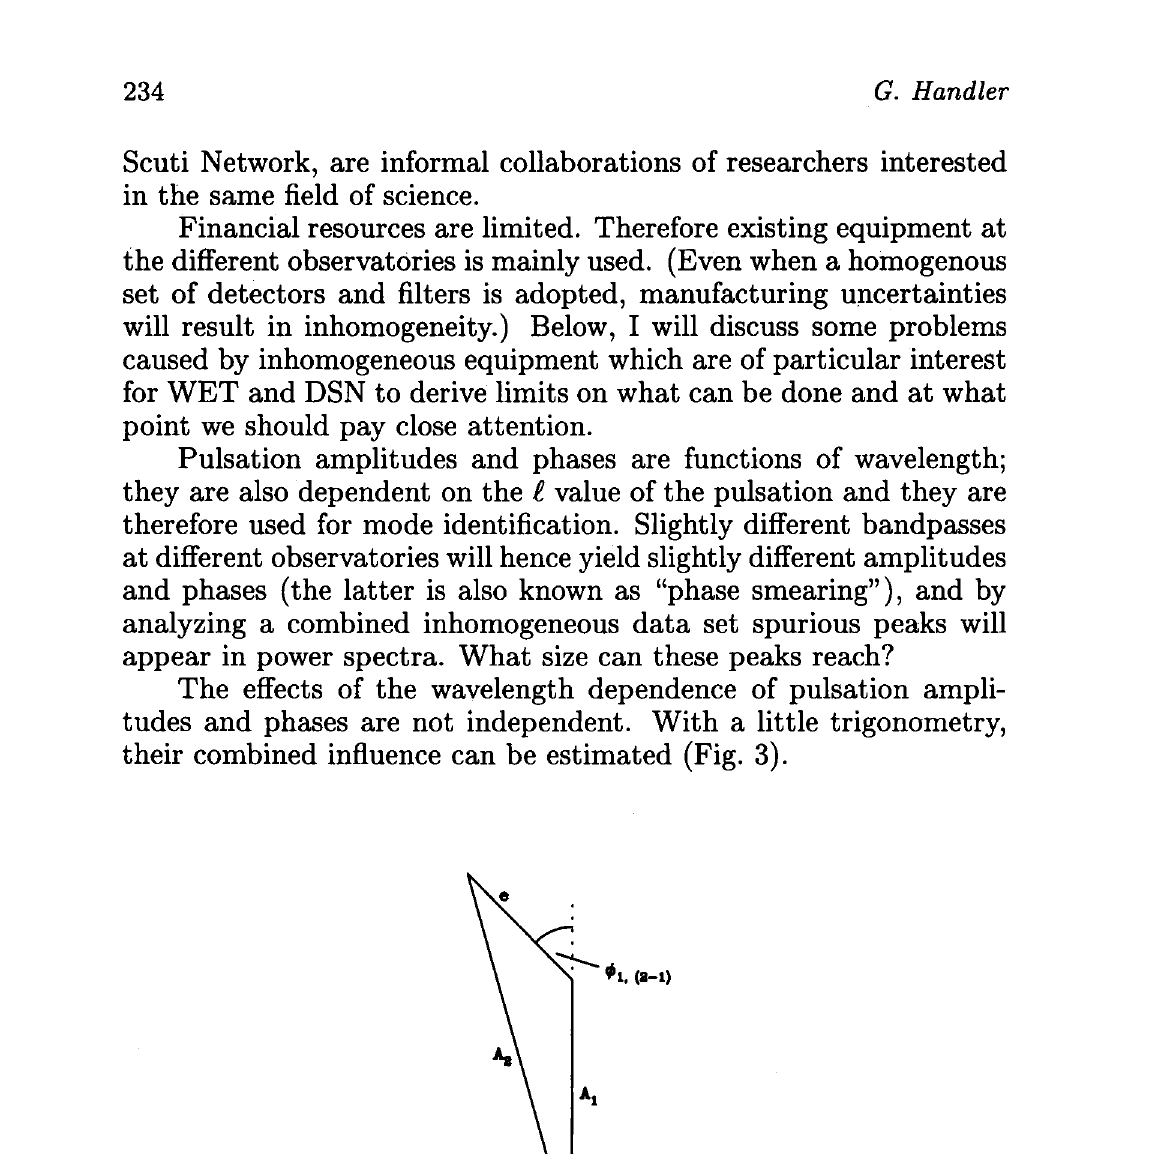
Fig. 3. Pulsation amplitudes and phases at different effective wave-